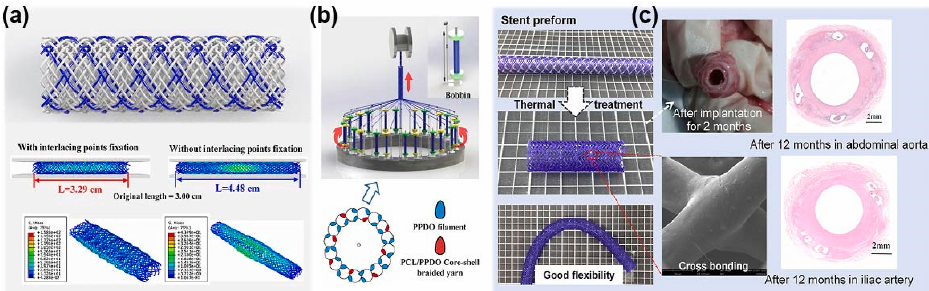
Figure 2. Design ( a ), processing ( b ), and implantation ( c ) of braided mechanical self-reinforcing composite stent.